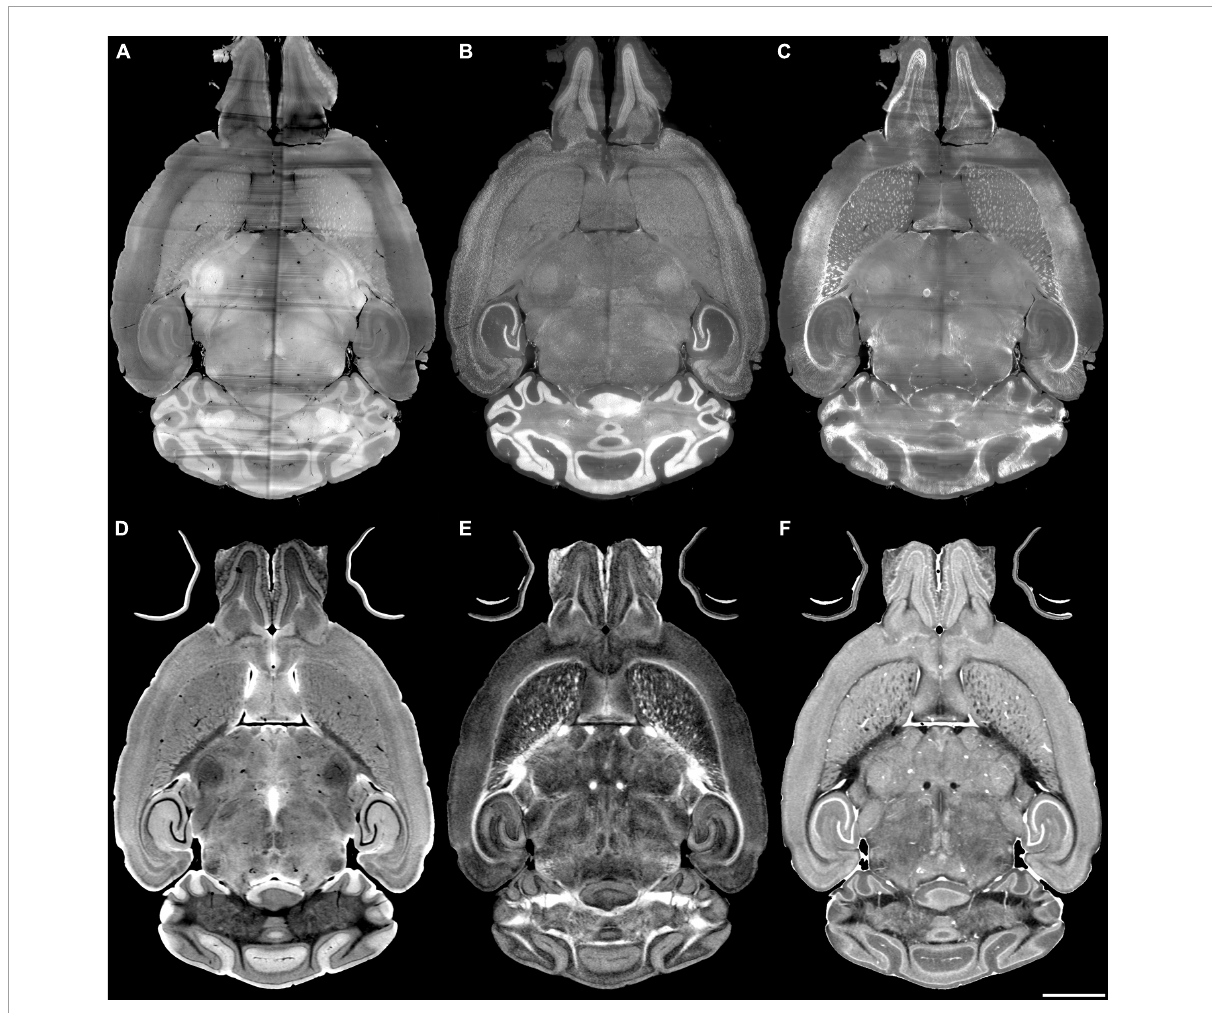
FIGURE4 Light sheet microscopy of different stains and MRH of different contrasts. (A) Auto fluorescent, (B) NeuN, (C) MBP, (D) DWI, (E) FA, (F) RD scale bar is 2 mm (specimen